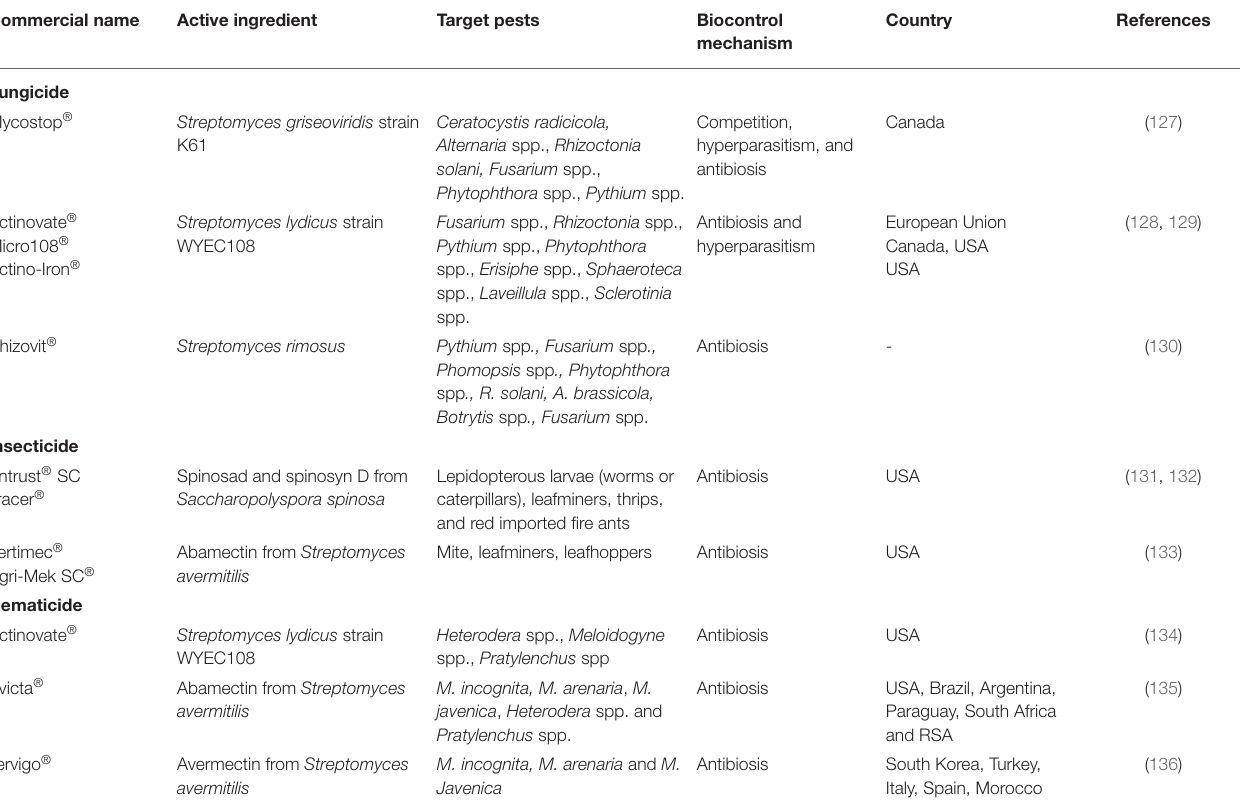
TABLE 1 | Commercialized actinomycete-based